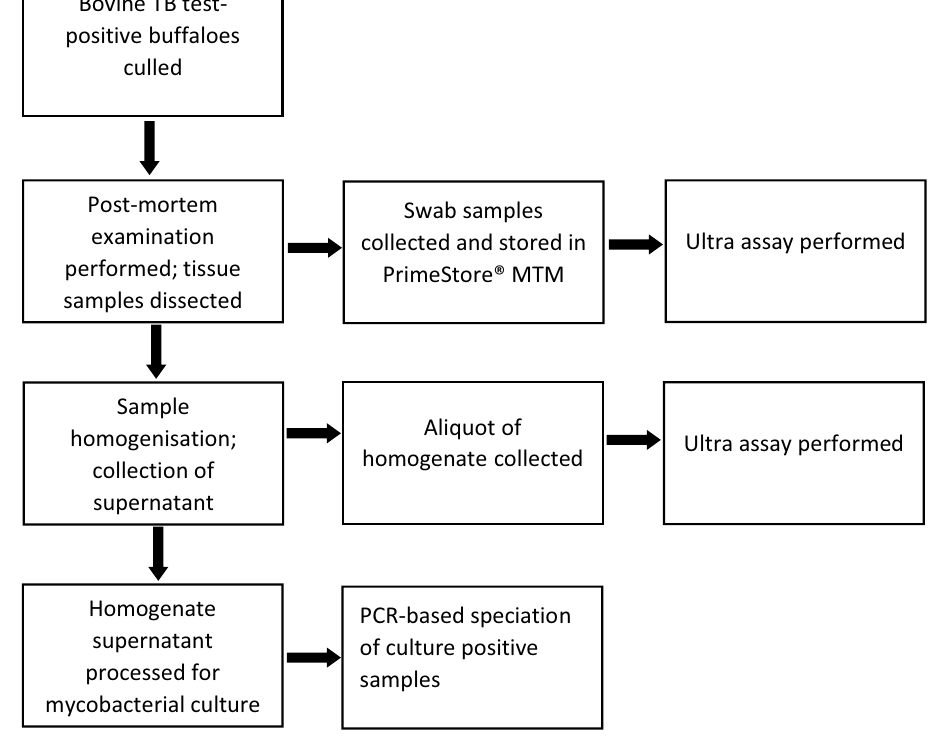
Figure 1. Study method flow chart for African buffaloes from the bTB-endemic game reserve, HiP